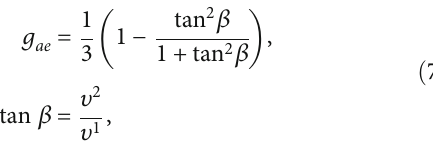
Figure 6: Isoscalar and isovector distribution of 23 Na spin-reduced matrix elements from J photoproduction. We should mention that the energy of the emitted photon is E γ = E corresponds to the gs to gs